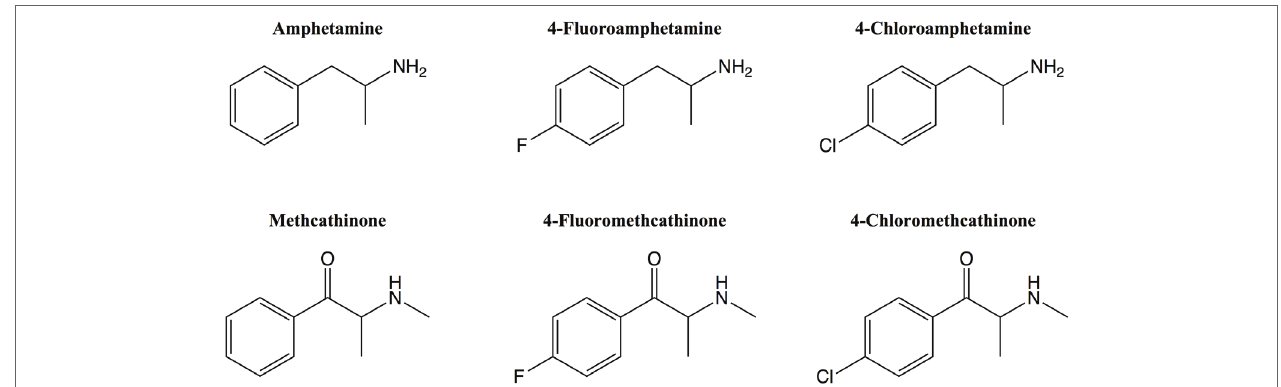
FIGURE 1 | Para -halogenated amphetamine and methcathinone